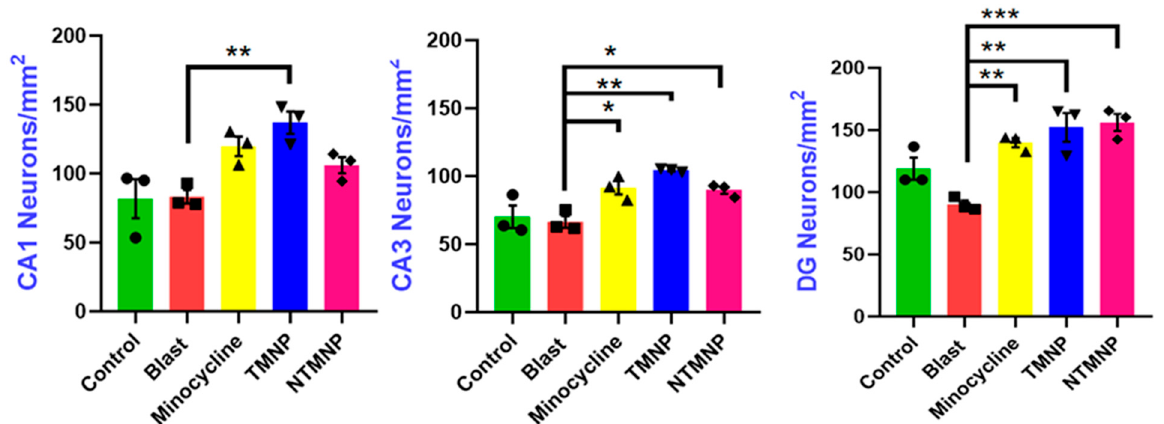
Figure 12. Free minocycline, targeted (TMNP), and non-targeted minocycline (NTMNP) nanoparticles showed neuroprotection against blast-induced neuronal cell death ( n = 3). * p < 0.05, ** p < 0.01, *** p < 0.001